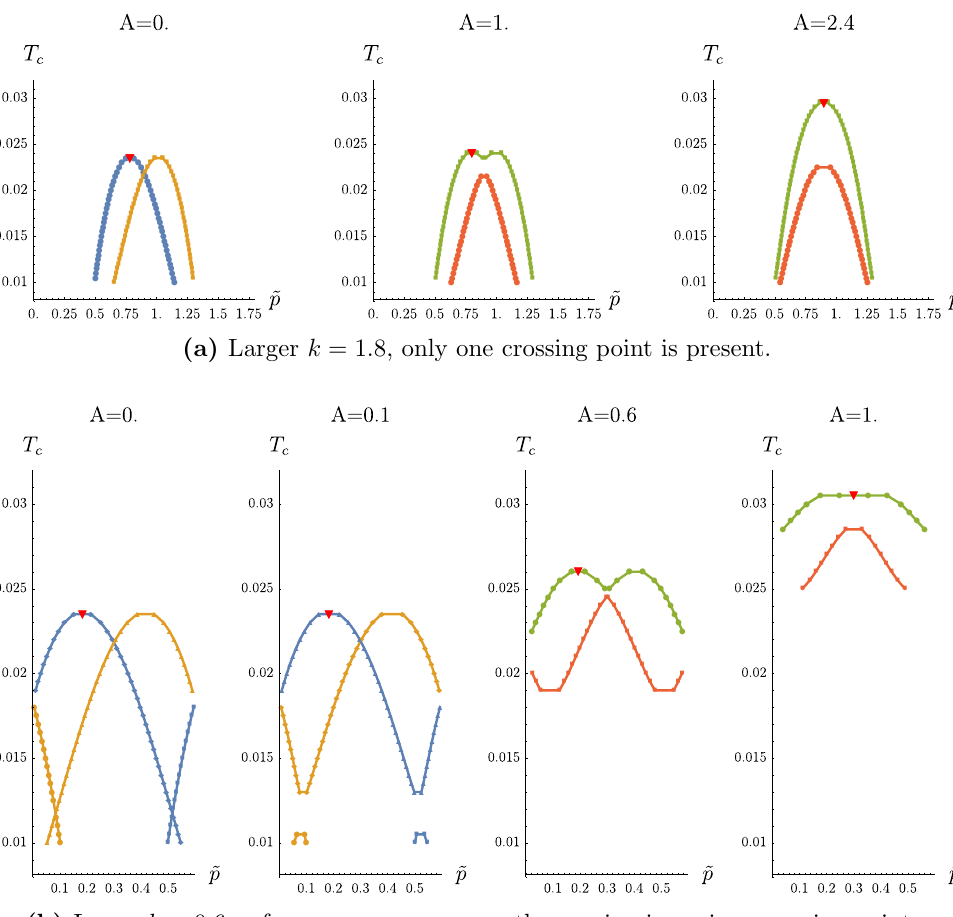
Figure 4 . Modi(cid:12)ed instability curves of the striped marginal mode on top of the ionic lattice background for di(cid:11)erent lattice wave-vector and amplitude. At large amplitude the commensurate value ~ p c = k= 2 has the largest critical